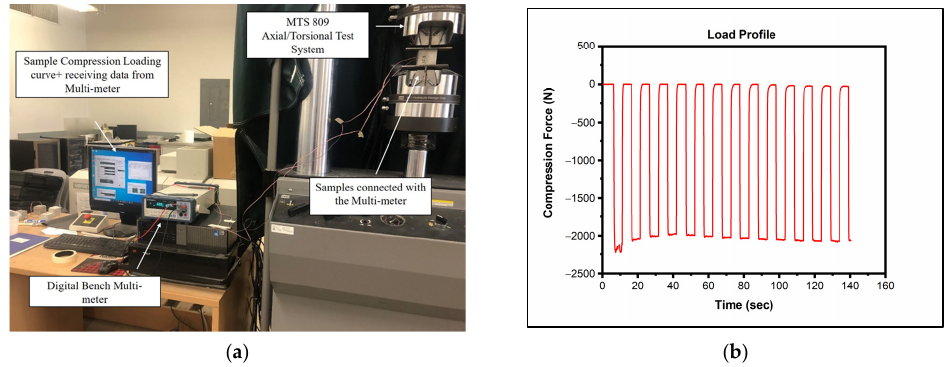
Figure 3. ( a ) Laboratory setup for full experimental setup. ( b ) Dynamic loading curve.